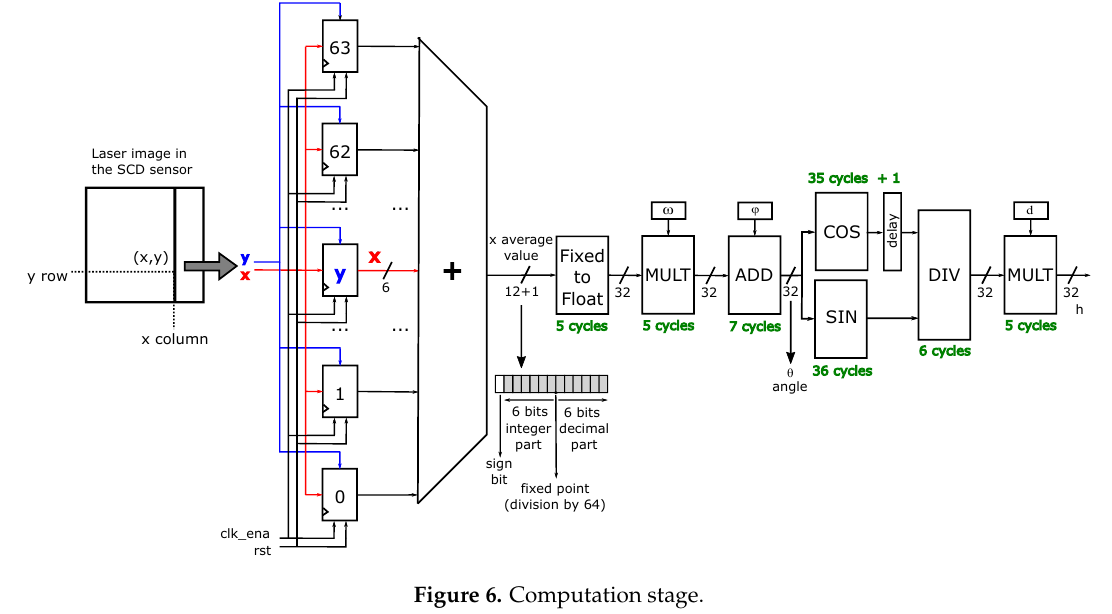
Figure 6. Computation